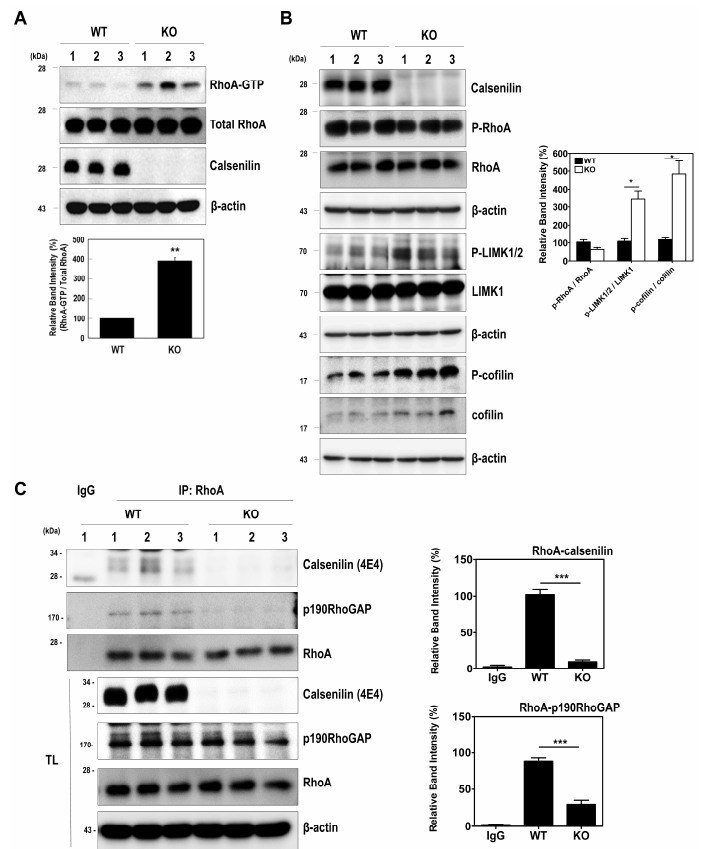
Figure 3. Calsenilin regulates RhoA inactivation and the RhoA-ROCK-LIMK-cofilin pathway in the mouse brain:( A ) detection of RhoA-GTP levels in the brain of wild-type (WT) and calsenilin knockout (KO) mice; ( B ) phosphorylation levels of RhoA, LIMK, and cofilin in the whole brain lysates of WT and calsenilin-KO mice; and ( C ) co-immunoprecipitation of RhoA with calsenilin (anti-4E4) [19] and p190RhoGAP in the whole brain lysates of WT and calsenilin-KO mice. The intensities of the bands in each panel were measured and quantified for each group, and the values are expressed as the mean SEM of three independent experiments ( n = 3, * p < 0.05; *** p < 0.001).